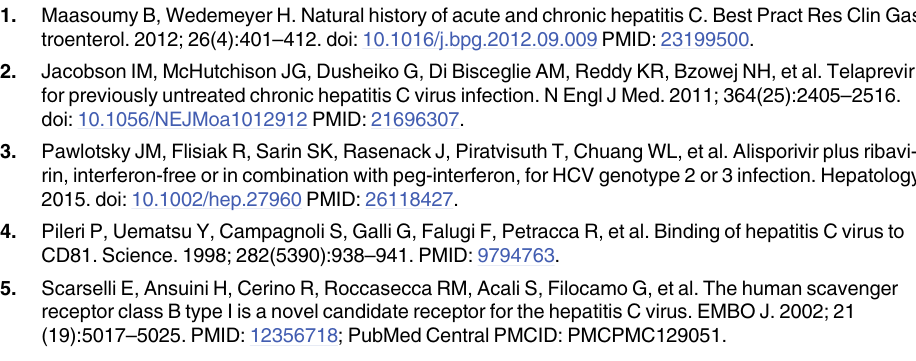
immunoblotting analysis (upper panel). Cells were infected with HCVcc at an MOI of 1 and intracellular HCV RNA levels were determined at 24, 48, 72 h post-infection by qRT-PCR (middle panel). Cells were infected with HCVcc at an MOI of 1 and subjected to immunofluo- rescence analyses by using antibodies against NS5A at 72 h post-infection (lower panel). S5 Fig. Cell surface expression of lipoprotein receptors. S112F- and T175A-SR-B1 missing lipid binding ability (A), Δ LBD of LDLR and VLDLR deleted the ligand binding domains (B), and mut5 and mut2-7 in which asparagine residues in the repeat 5 and in the repeats 2 to 7 of LDLR were substituted with tyrosine (C) were generated. The wild-type and these mutants of SR-B1, LDLR and VLDLR were expressed in SR/LD-DKO Huh7 cells by lentiviral vectors and cell surface proteins were biotinylated and purified by Cell Surface Protein Biotynylation and Purification Kit. Expressions of the repoprotein receptors, EGFR and actin in whole cell lysate and purified proteins were examined by immunoblotting. EGFR and actin were used as a marker of membrane and cytosolic protein, respectively. (D) Lipid uptake activities of mutants of lipoprotein receptors were determined by using lipid transfer assay. Parental Huh7 cells and SR/LD-DKO Huh7 cells expressing either wild-type or mutants of SR-B1, LDLR and VLDLR were incubated with DMEM containing 0.5% fatty acid-free bovine serum albumin and either 5 μ g DiI-HDL or DiI-LDL for 2h at 37°C, washed twice with PBS, and examined by a laser scan- ning confocal microscope. HDL (E) and LDL (F) uptake activities of parental Huh7 cells and SR/LD-DKO Huh7 cells expressing either wild-type or mutants of SR-B1 were determined by using HDL Uptake Assay Kit and PowerScanHT, respectively. In all cases, asterisks indicate significant differences ( (cid:1) P < 0.05; (cid:1)(cid:1) P < 0.01) versus the results for Huh7